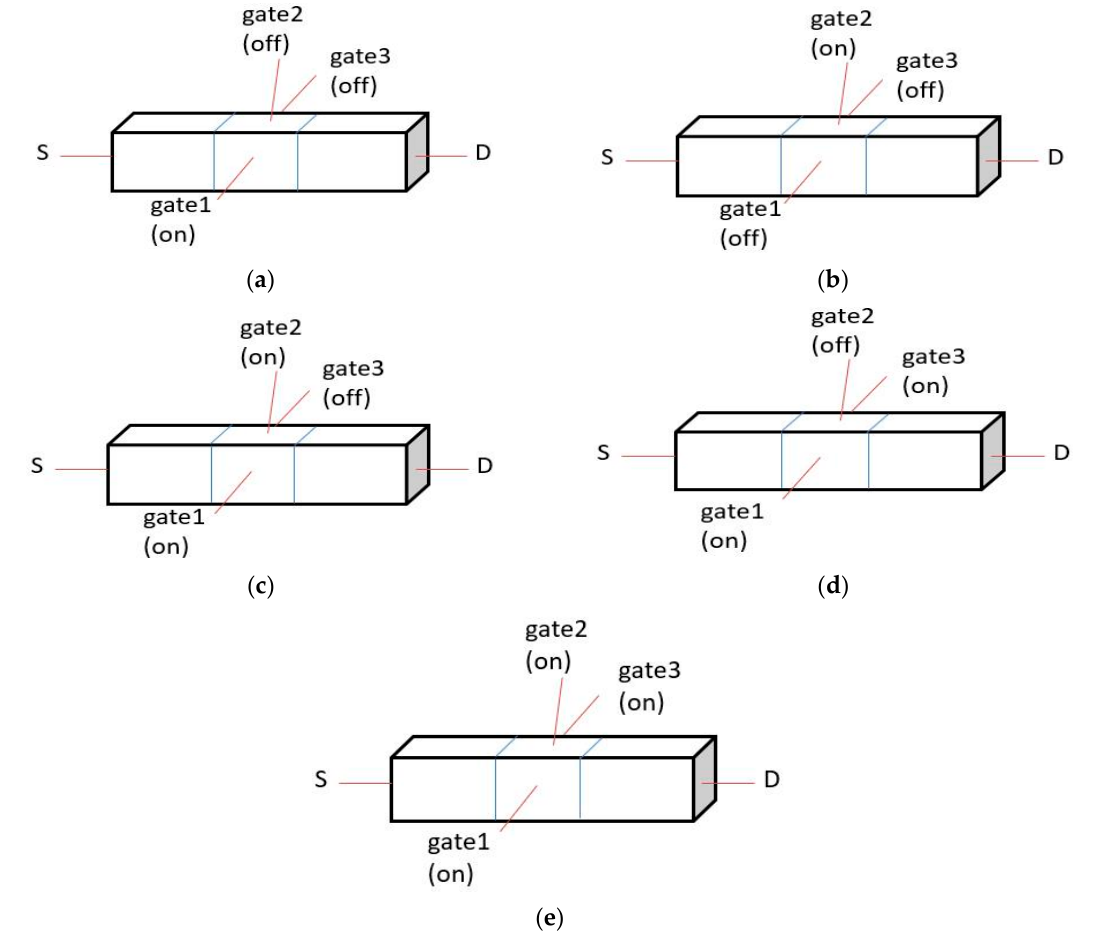
Figure 4. Working mode diagram: ( a ) MODEL1 mode state; ( b ) MODEL2 mode state; ( c ) MODEL3 mode state; ( d ) MODEL4 mode state; ( e ) MODEL5 mode state.